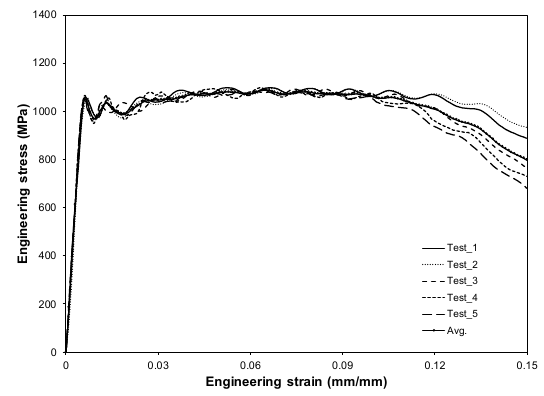
Fig. 9. Experimental engineering stress strain for Material 2 at 100 s -1 .